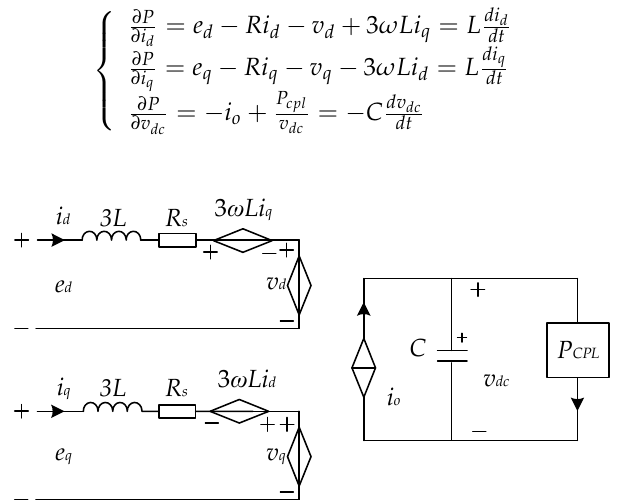
Figure 3. The equivalent circuit of three-phase VSR with CPL in dq coordinates. This indicates that Equation (9) satisfies the form Equation (3), which proves that the mixed potential function P is correct.